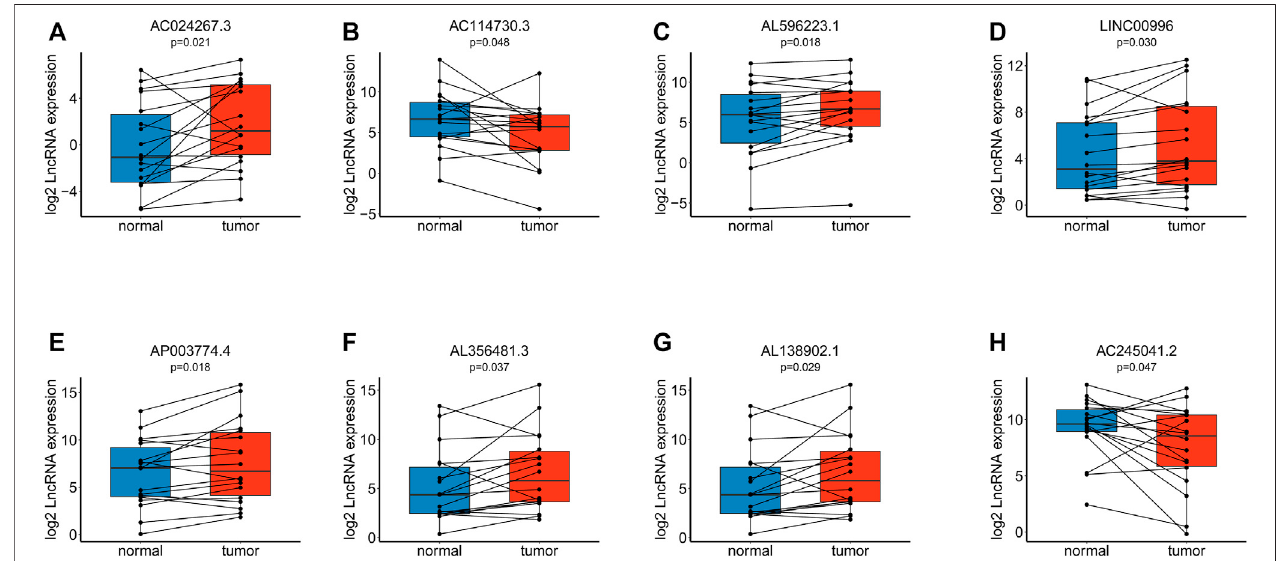
FIGURE 10 | Veri fi cation of the model via RT – qPCR among eighteen paired tissues. (A) . Expression of AC024267.3. (B) . Expression of AC114730.3. (C) . Expression of AL596223.1. (D) . Expression of LINC00996. (E) . Expression of AP003774.4. (F) . Expression of AL356481.3. (G) . Expression of AL138902.1. (H) . Expression of